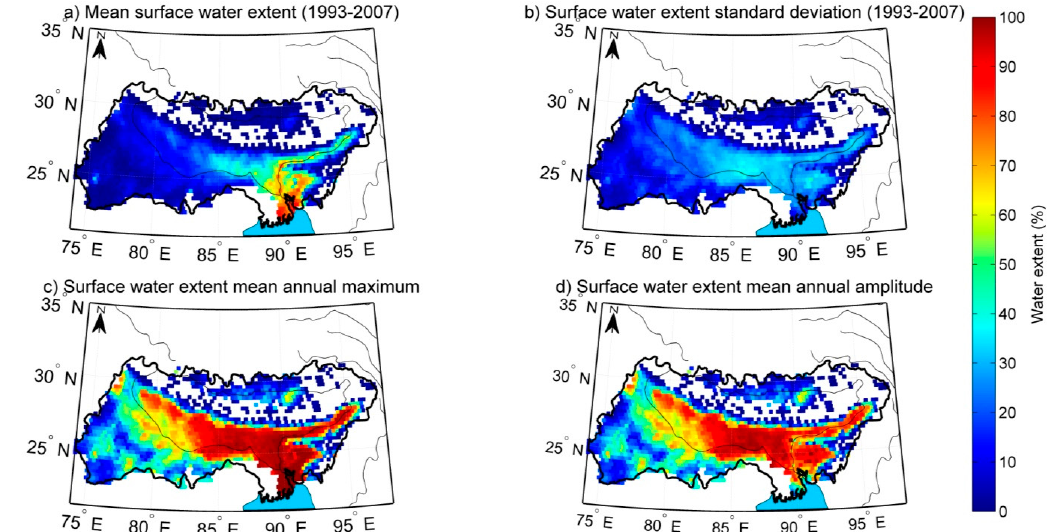
Figure 2. Main characteristics of the spatial distribution of the surface water extents provided by Global Inundation Extent Multi-Satellite (GIEMS) for the Ganges-Brahmaputra (GB) basin (all values as areal fractions of 773 km 2 GIEMS cells): ( a ) Mean surface water extent for the 1993–2007 period; ( b ) Associated standard deviation; ( c ) Mean annual maximum; ( d ) Mean annual amplitude.